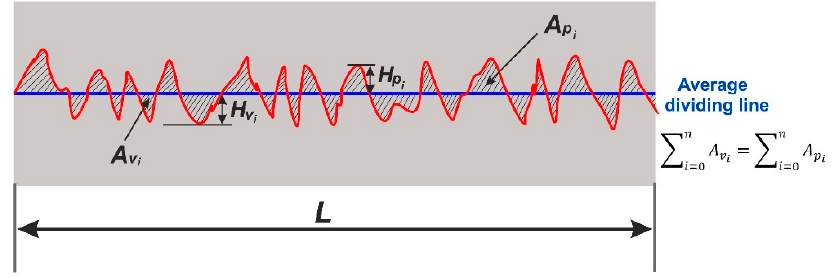
Figure 5. An example of the surface roughness profile along the measurement section for the selected area on the surface of the fracture face.